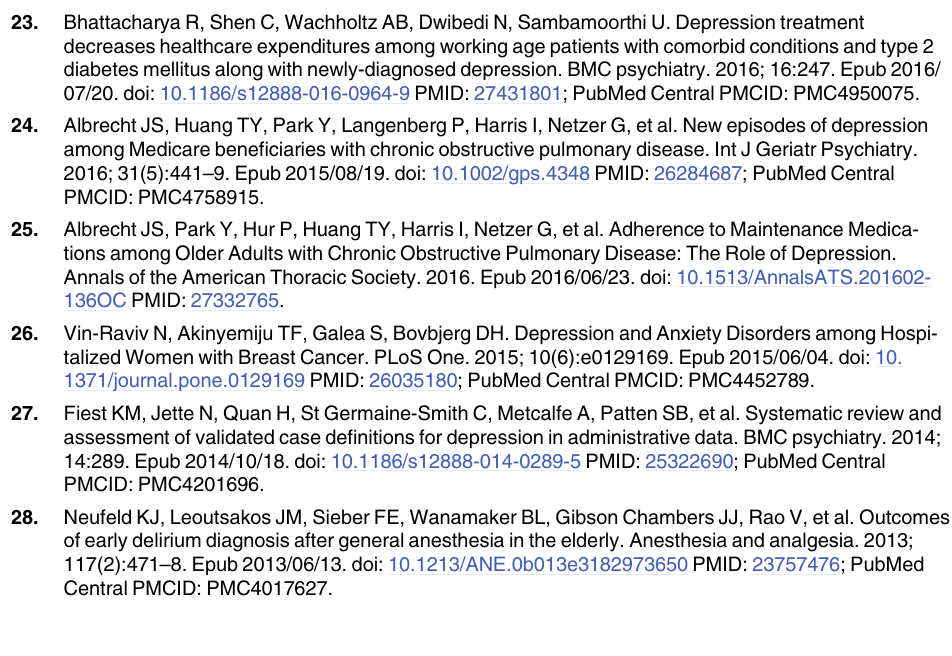
PLOS ONE | DOI:10.1371/journal.pone.0165517 November 7,